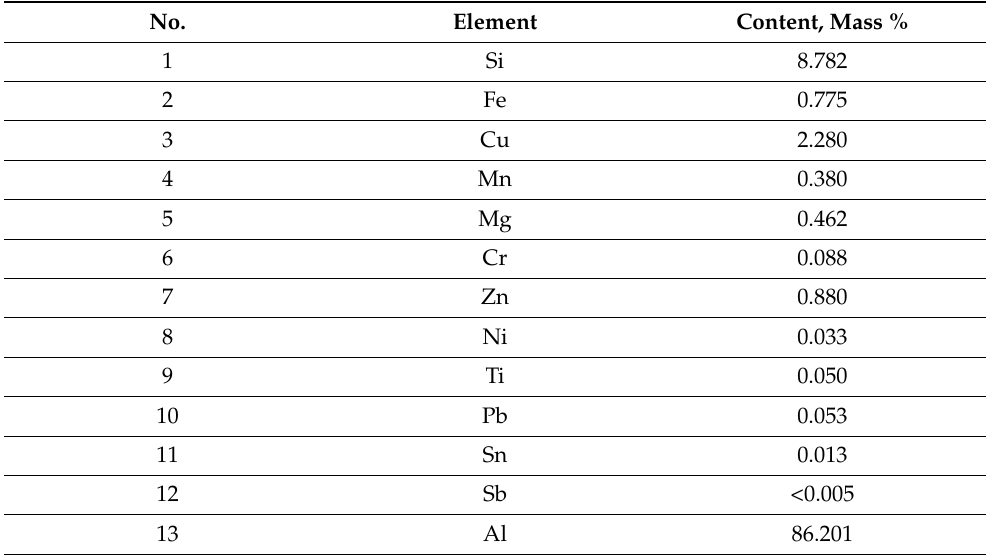
Table 1. Chemical composition of the experimental alloys. No. Element Content, Mass